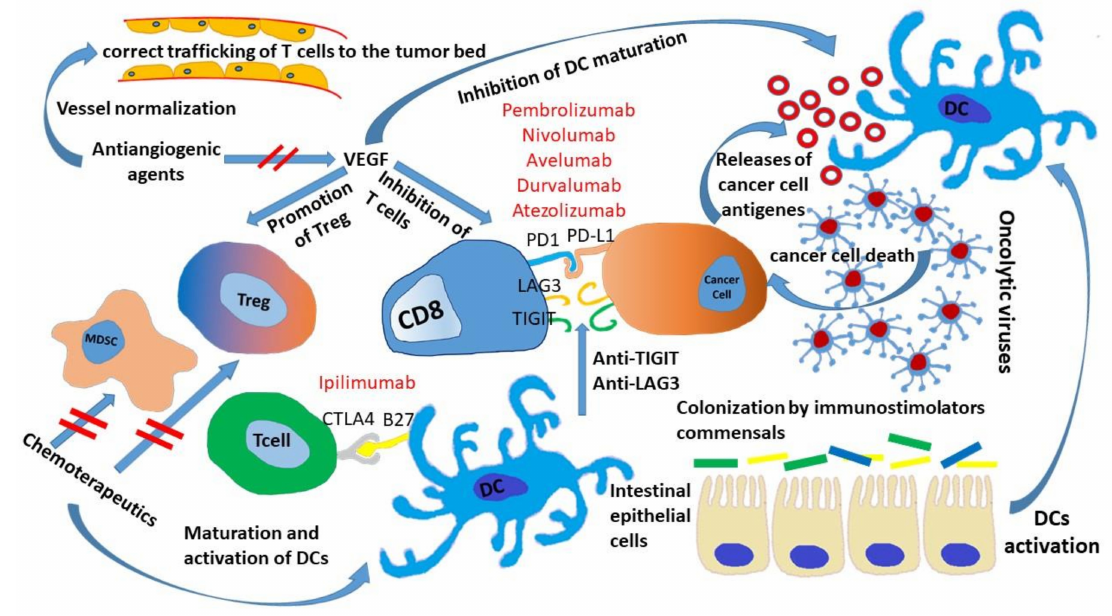
Figure 2. Summarizes the mechanisms implicated in improving the e ffi cacy of immune checkpoint inhibitors (ICIs): The influence of microbiota on dendritic cell (DC) maturation and activation; the correct tra ffi cking of T cells to the tumor bed due to the normalization of endothelium by anti-angiogenic drugs and the VEGF immunosuppressive activity; the impact of chemotherapy on immunosuppressive cells and on DC maturation; release of damaged molecular patterns after oncolytic viruses induce tumor cell